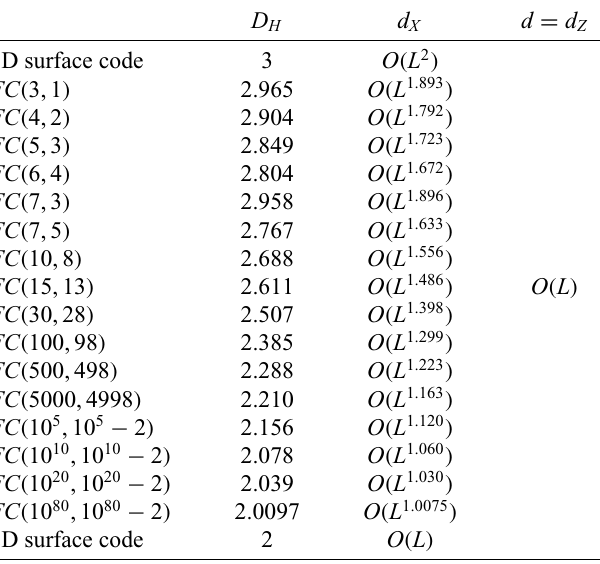
TABLE I. The Hausdorff dimensions and code distances of a set of fractal surface codes defined on the fractal-cube geome- tries FC ( p , q ) (including the generalization to the Z N cases), compared with those of the 2D and 3D surface codes. D H d X d = d Z 3D surface